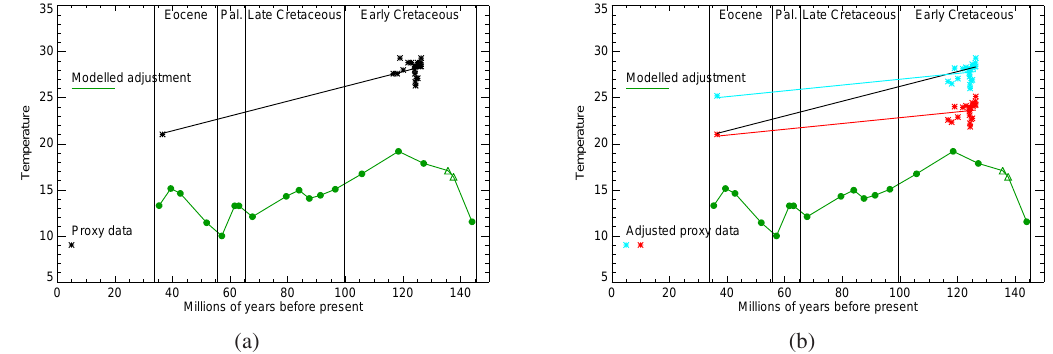
Figure 10. (a) Proxy temperature data (black asterixes) at Falkland plateau (Site 511) from TEX 86 . Eocene data are from Liu et al. (2009), and Cretaceous data from Jenkyns et al. (2012). Black line shows the line of best fit. Also shown is the modelled temperature evolution at Falkland plateau (green line), i.e. the adjustment factor. In (b) , the proxy data have been adjusted using the model output, relative to either the earliest (light blue) or latest (red) proxy data point. Blue and red lines show the respective lines of best fit. TEX 86 temperatures are calculated using the TEX H -SST calibration of Kim et al. 86